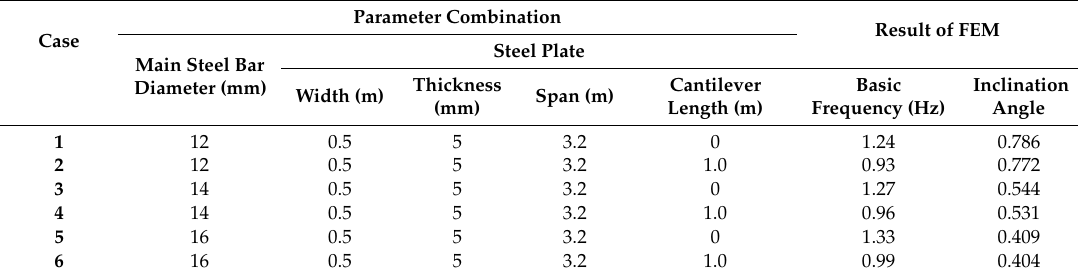
Table 2. Result of the finite element model (FEM) from six cases of di ff erent parameter